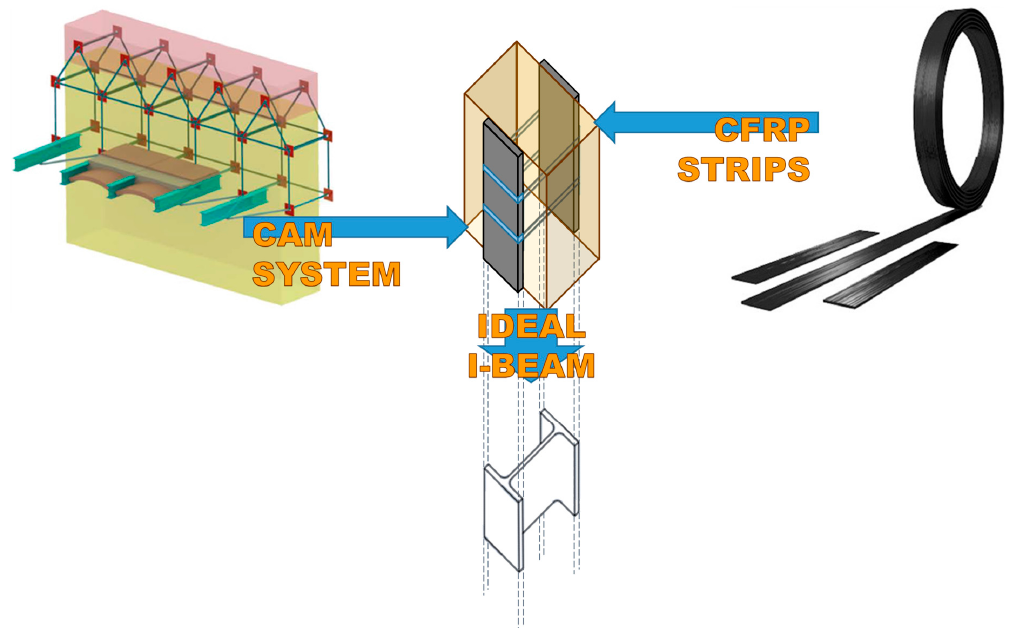
Figure 17. How the ribbons of the CAM system and the CFRP strips work together to provide a bracing effect in the thickness, which is similar to that given by an embedded I-beam acting as a